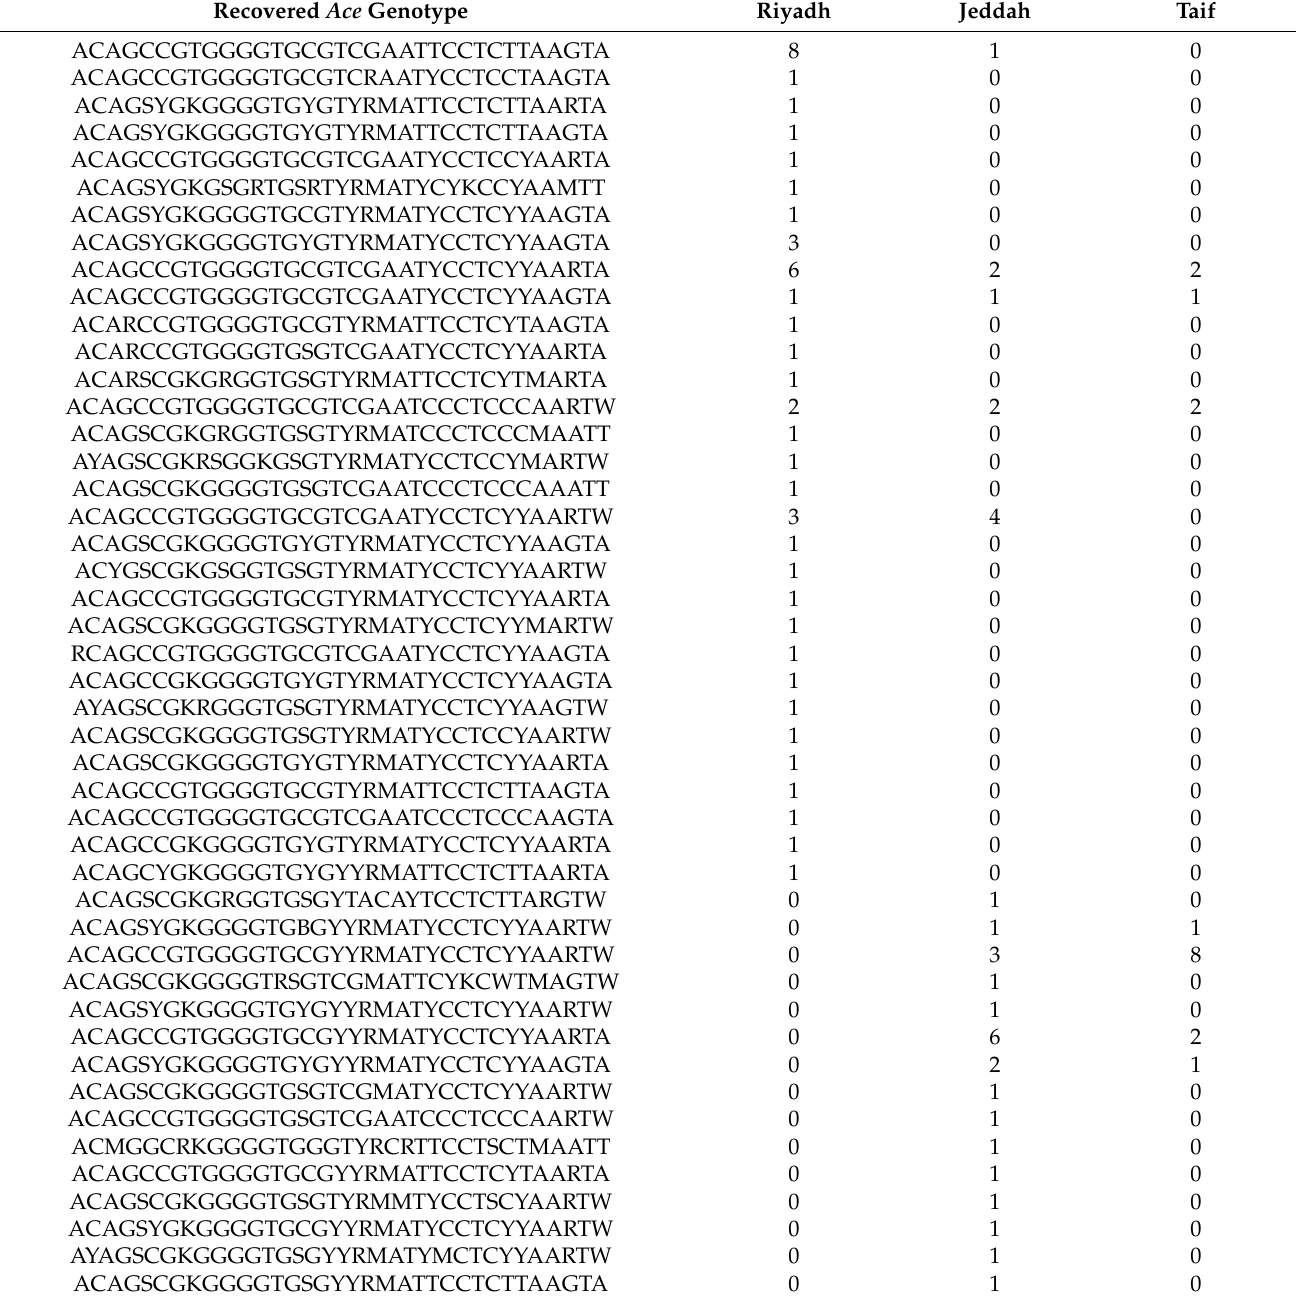
among the 23 singletons. A total of 8 Ace genotypes (5 were not recovered from the field population) were found among the 10 survivors of Taif F1, with 7 singletons; the eighth one had 3 individual flies (Table 5). Based on the F is estimates, with probabilities very close to zero, the three field populations showed deviation from Hardy–Weinberg equilibrium (Table 5). The values of the pairwise F ST estimates for the Ace genotypes of three housefly field populations were very low, along with high gene flow (Nm ≥ 8), indicating that there is little genetic differentiation among these populations (Table 6). Table 5. Ace genotypes recovered from Saudi field house fly populations and their F is estimates of HWE test. Recovered Ace